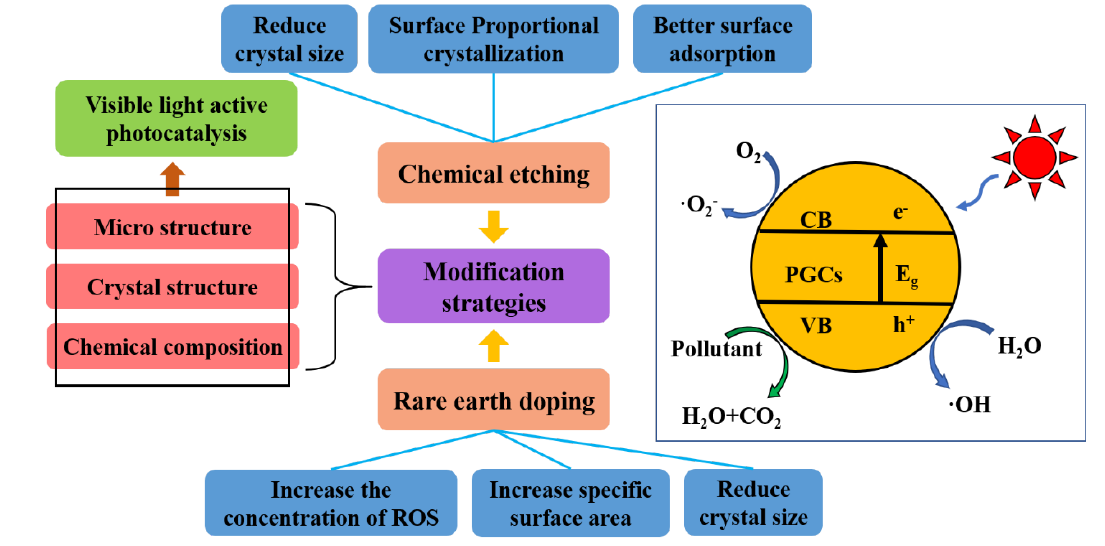
Figure 22. Summary of modification engineering for PGCs.